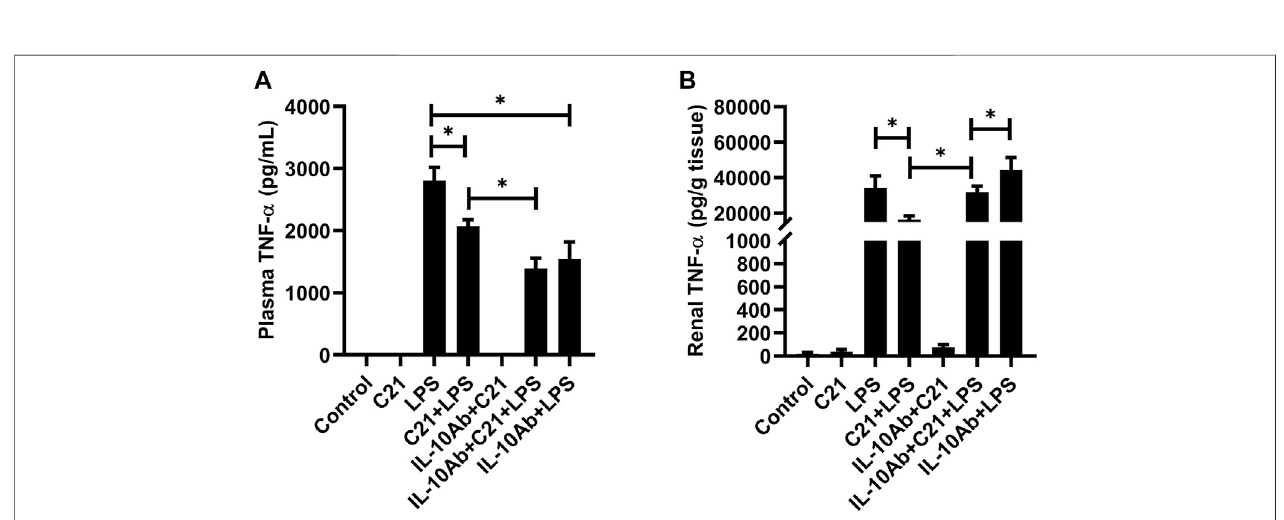
FIGURE 4 | TNF- α concentration in the (A) plasma and (B) kidney of C57BL6/NHsd mice treated with C21, LPS, or both with and without neutralizing IL-10 antibody. Data are represented as Mean ± S.E.M., analyzed by one-way ANOVA with Fisher ’ s LSD test for multiple comparisons and are considered signi fi cant at * p <